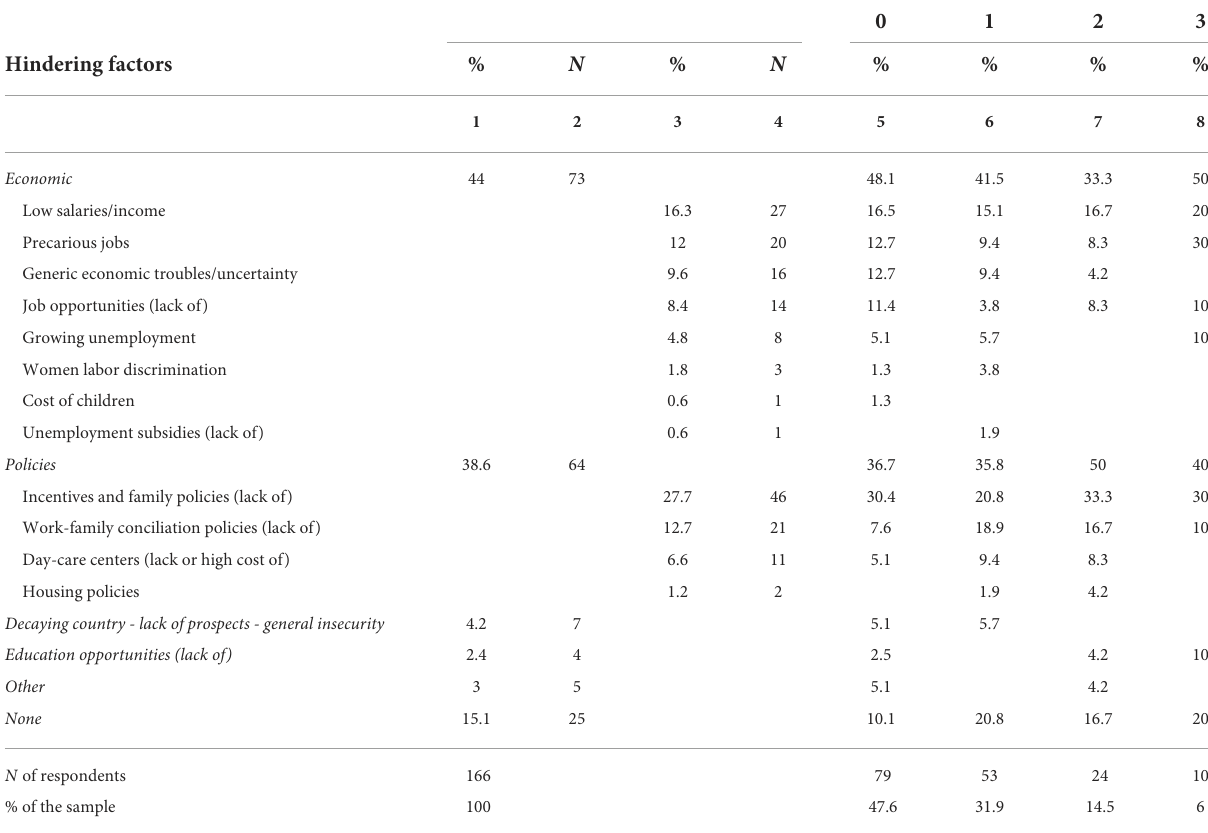
TABLE 3 Codes and subcodes frequencies of the macro-economic hindering factors to fertility intentions for the unachieved fertility capability group with distribution among different